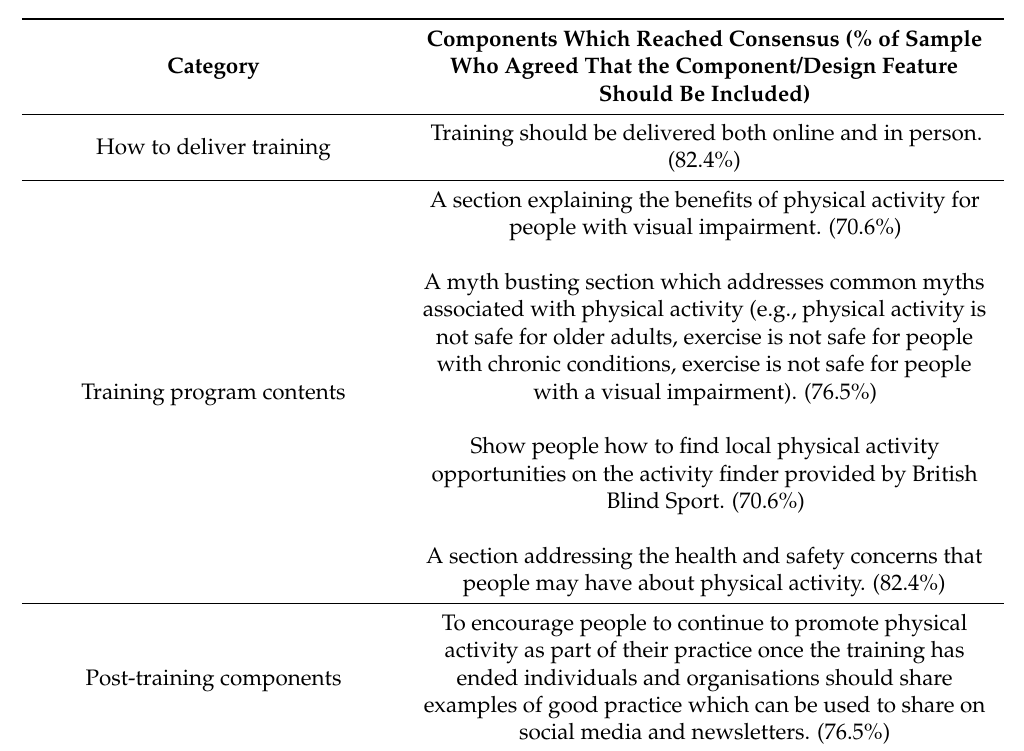
Table 2. Components which reached consensus in round one.